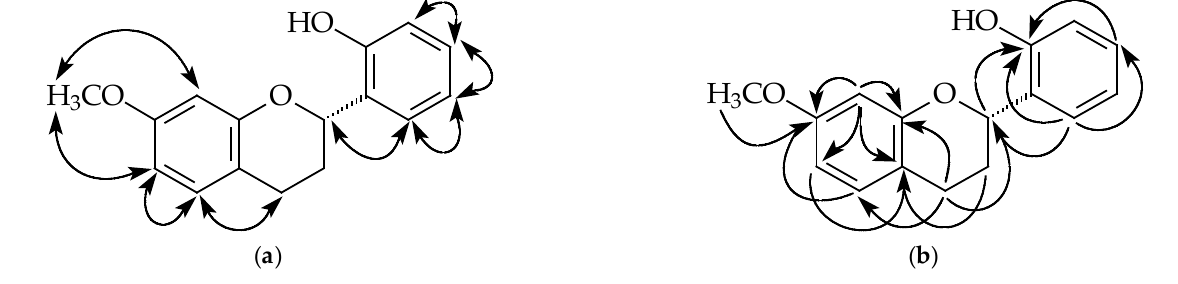
Figure 3. Key NOESY contacts ( a ) and HMBC connectivities ( b ) of compound 2 . Compound 3 was isolated as a brown oil. Its molecular formula, C 16 H 16 O 3 , was determined by HREIMS ([M] + , 256.1104). The 1 H-NMR spectrum (Table 1 and Figure S23) of 3 showed five aliphatic protons at δ 2.26, 2.80, 2.96, and 5.18, typical of pyran nucleus protons of a flavan, one set of ABX system phenyl protons [ δ 6.46 (d, J = 2.4 Hz), 6.52 (dd, J = 8.4, 2.4 Hz), 7.00 (d, J = 8.4 Hz)], four aromatic protons at δ 6.90, 6.91, 7.14, and 7.20, a methoxy singlet at δ 3.75. Since the NOESY experiment of 3 (Figure 4) showed that protons at δ 7.00 correlated with δ 6.52 and H-4, δ 7.00 and 6.52 were assigned to H-5 and H-6, respectively. The methoxy singlet owning correlation with H-6 and δ 6.46 suggested the methoxy group at C-7 and δ 6.46 was assigned to H-8. 13 C-NMR spectrum (Table 2 and Figure S21) of 3 showed three oxygenated quaternary C-atoms ( δ 154.4, 154.7, 159.1) suggesting a hydroxyl group on B-ring. The NOESY correlations (Figure 4 and Figure S23) of four aromatic protons ( δ 6.90, 6.91, 7.14, and 7.20) suggested the hydroxy group at C- 2′ . An S - configuration at C-2 of 3 was due to the negative optical rotation { −26.0 ° ( c 0.01, MeOH)} [28]. According to the above evidence, the structure of 3 was elucidated as (2 S )-2’-hydroxy-7-methoxyflavan, which was further confirmed by COSY (Figure S22), NOESY (Figures 4 and S23), 13 C-NMR (Figure S21), DEPT, HMQC (Figure S24), and HMBC (Figures 4 and S25) experiments.